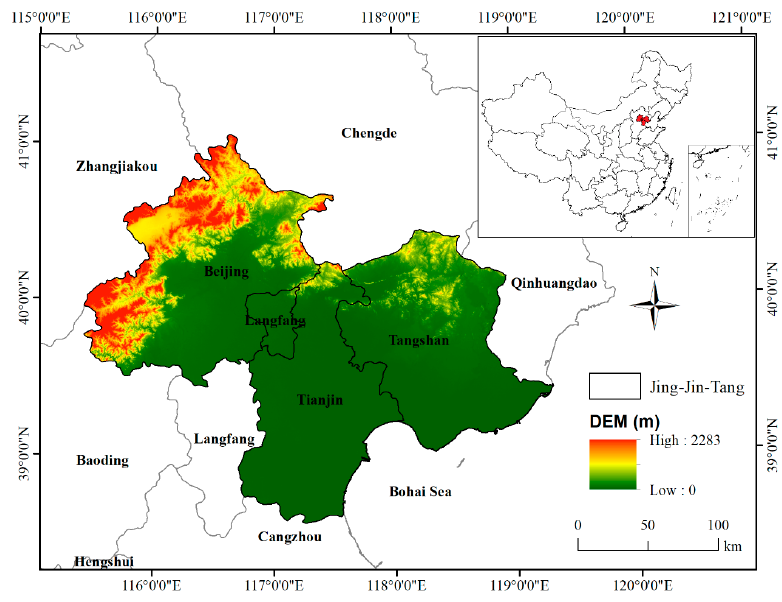
Figure 2. The location and elevation of the study area.